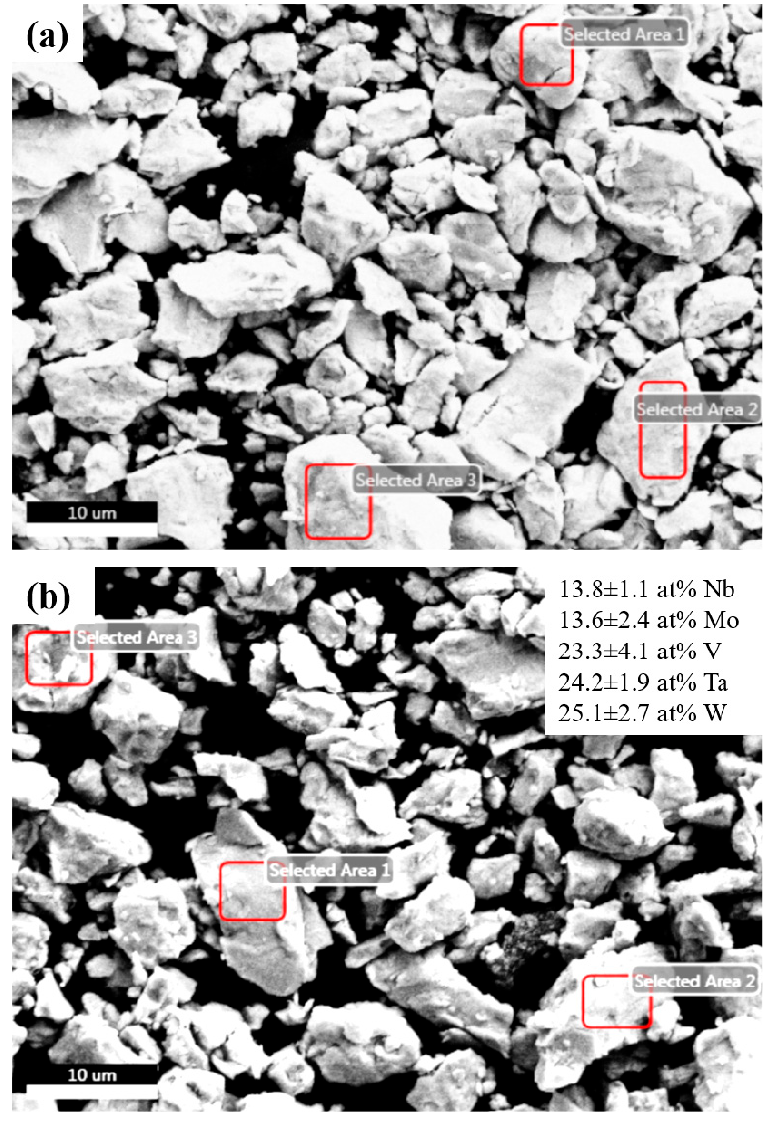
Figure 1. Microstructure and composition (average of six different measurements) of MoTaNbVW powder under SEM (Secondary electron mode). ( a , b ) represent two different areas where point analysis has been performed in 6 points in